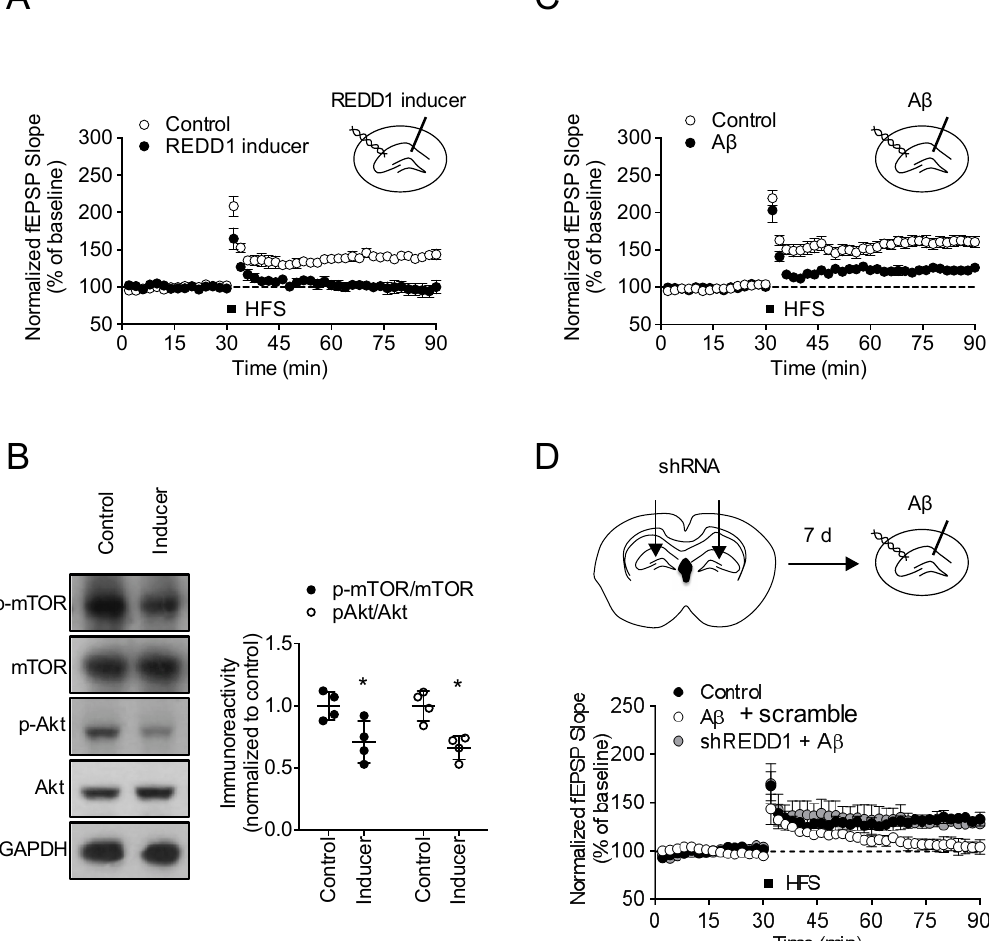
Figure 3. REDD1 is required for A β -induced synaptic dysfunction. ( A ) REDD1 inducer suppressed hippocampal long-term potentiation (LTP). Hippocampal slices incubated with REDD1 inducer (50 µ M) for 4 h. Data represented as mean ± SD. ( B ) REDD1 inducer suppressed mTOR signaling in the hippocampus. Data represented as mean ± SD with raw data. ( C ) A β suppressed hippocampal LTP. Hippocampal slices incubated with A β (1 µ M) for 4 h. Data represented as mean ± SD. ( D ) REDD1 knockdown blocked A β -induced LTP impairment. REDD1 shRNA (m) lentiviral particle or scramble lentiviral particle was bilaterally injected into hippocampal fissure layer. Hippocampal slices prepared and incubated with A β for 4 h, 7 d after lentiviral injection. Data represented as mean ± SD.